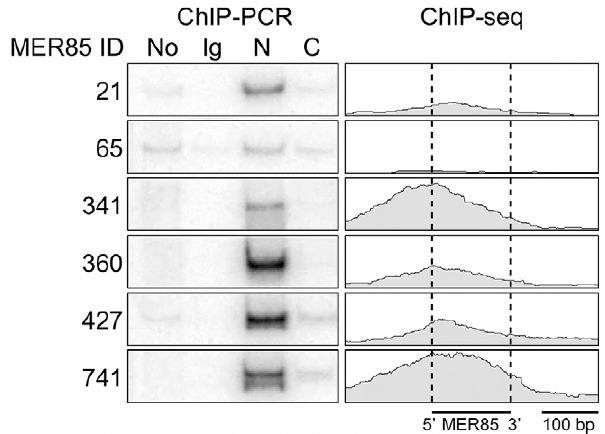
Figure 2. The CSB-PGBD3 fusion protein binds to MER85 elements in vivo . ( left ) ChIP-PCR in wild type HT1080 cells using antibodies for the N-terminus of CSB pulls down 6 representative MER85 elements with good matches to the Repbase consensus. N- terminal antibodies pull down both CSB-PGBD3 fusion protein and full- length CSB, whereas C-terminal antibodies pull down full-length CSB only (LTG unpublished). No, no antibody control; Ig, anti-mouse IgG nonspecific antibody control; N, CSB N-terminal antibody; C, CSB C- terminal antibody ( right ) Paired-end ChIP-seq shows enrichment for the same five out of six MER85 elements in CSB-null UVSS1KO cells stably expressing the CSB-PGBD3 fusion protein. Table S1 gives the positions and sequences of all MER85 elements. The 5 9 and 3 9 ends of MER85s are defined as the same orientation as the transposase ORF in parental PGBD3